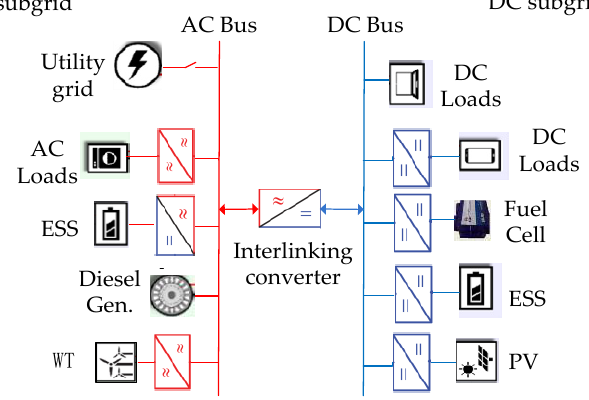
Figure 1. Layout of the AC/DC hybrid microgrid (HMG).